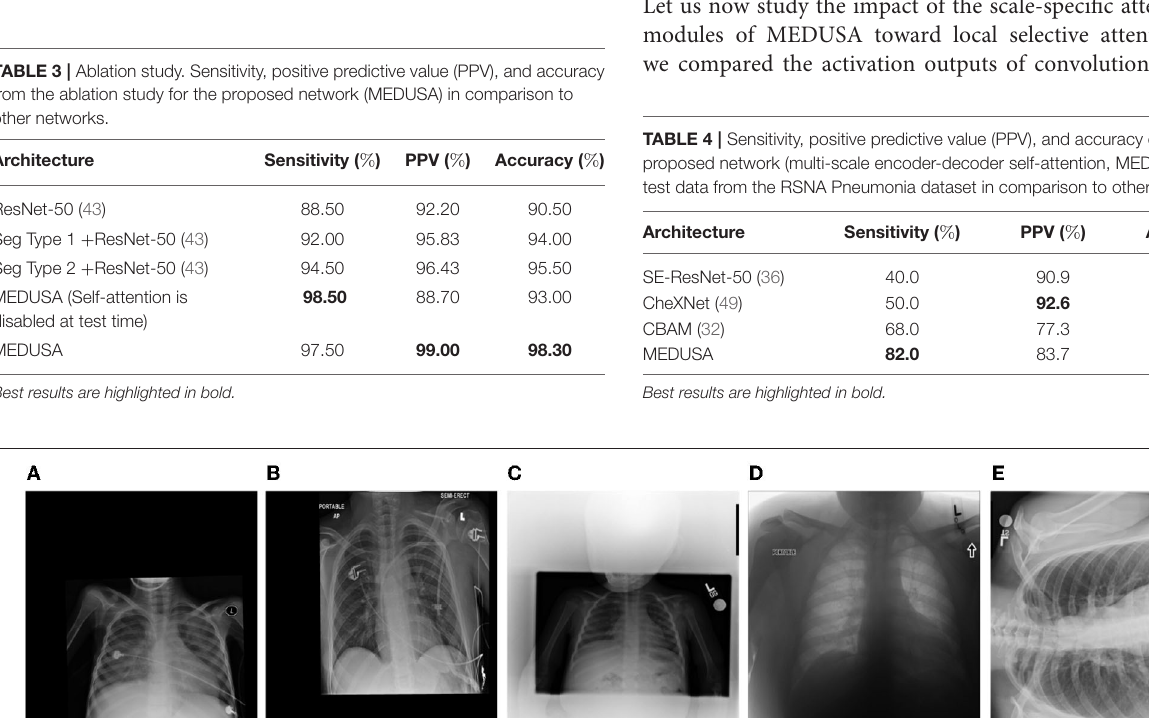
FIGURE 5 | Example chest X-ray images (labeled A–E ) with different types of significant distortions and visual anomalies from the Radiological Society of North America (RSNA) Pneumonia Challenge dataset.